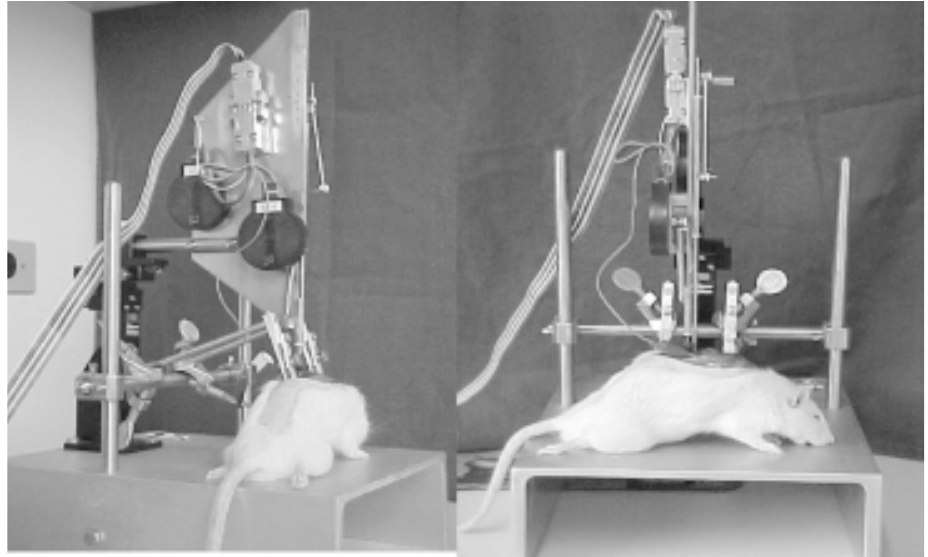
FIGURA 1 - Animal posicionado no aparelho